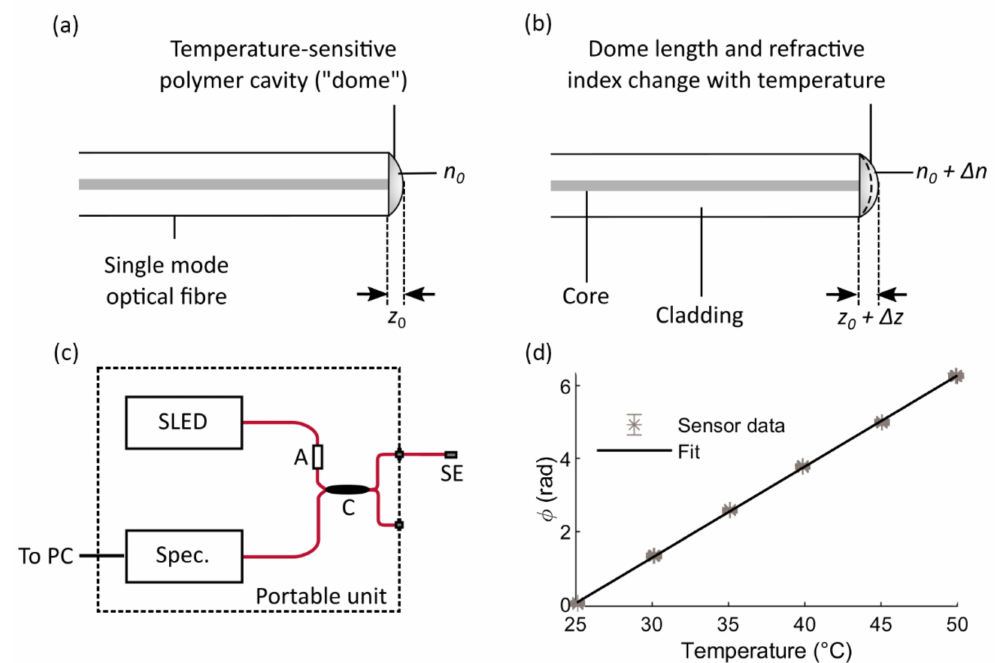
Figure 1. ( a ) Sensor schematic; ( b ) illustration of sensor operating principle. In both sub-figures, z 0 is the initial length of the dome; ∆ z : a small temperature-induced change in dome length; n 0 : the initial refractive index of the dome material; ∆ n : a small temperature-induced change in the dome refractive index. ( c ) Sensor interrogation setup; SLED: superluminescent light emitting diode; A: attenuator; C: 50:50 fibre-optic coupler; Spec.: spectrometer; SE: sensor element; red lines indicate single-mode fibre-optic cables. ( d ) Temperature calibration plot, where φ represents the phase (complex argument) of the interference pattern received by the spectrometer [45]; the solid black line indicates the least-squares line of best fit and the error bars indicate the standard deviation of φ at each temperature